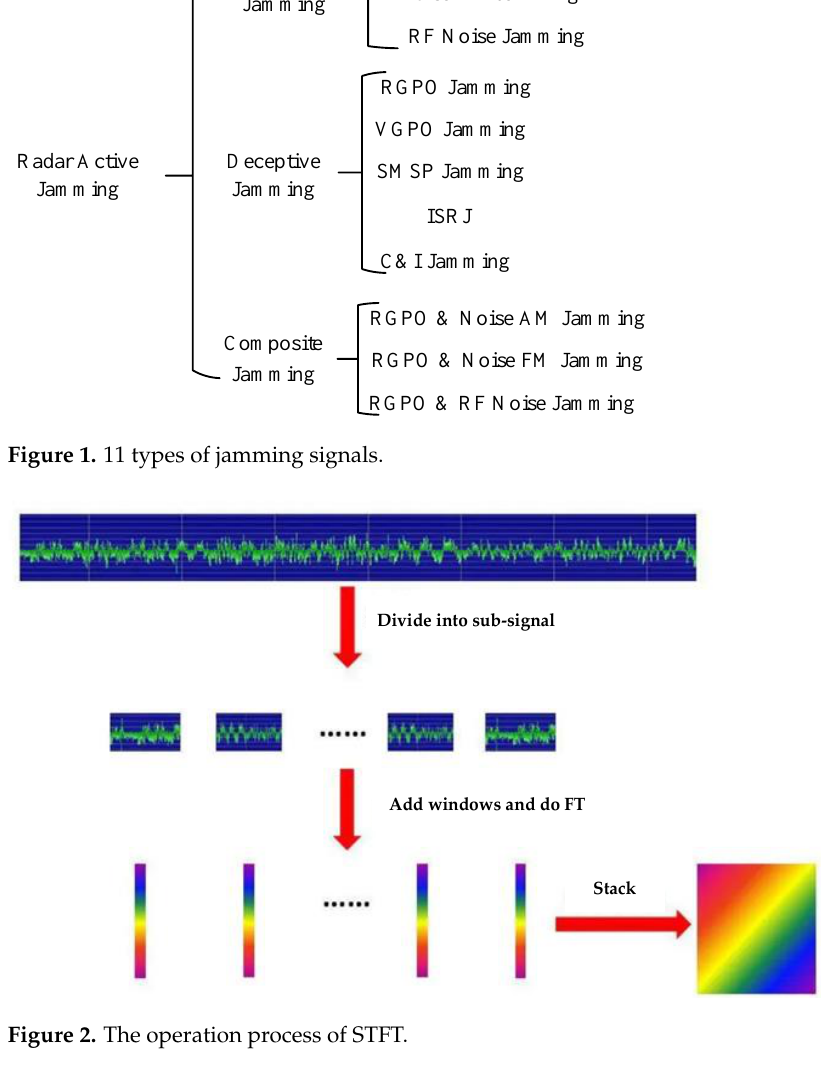
Figure 2. The operation process of STFT.